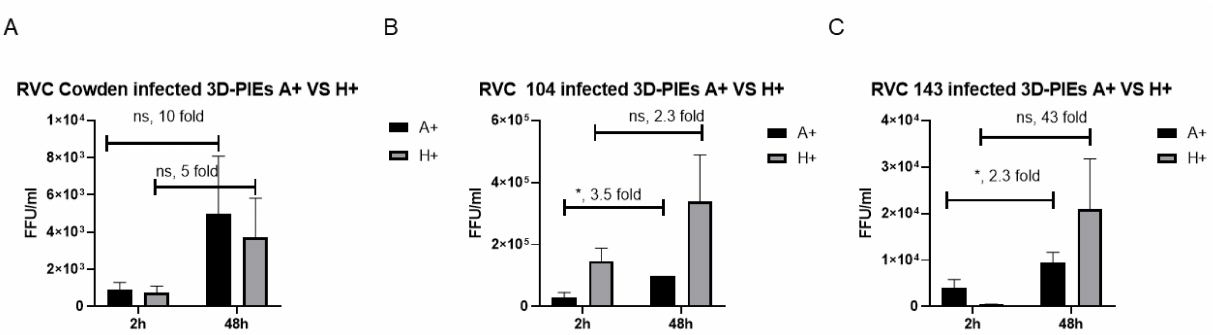
Figure 1. RVC replication in HBGA-A+ and HBGA-H+ PIEs. RT-PCR infectivity in A+ (black), H+ (gray) for ( A ) PRVC Cowden, ( B ) PRVC104, and ( C ) PRVC143. RVC titers were examined at 2 h and 48 h. Error bars are denoted as the standard deviation, and all experiments were repeated independently at least twice. Ns denotes no significant difference. Capped lines indicate the fold- changes between two groups. For p -value: * p <